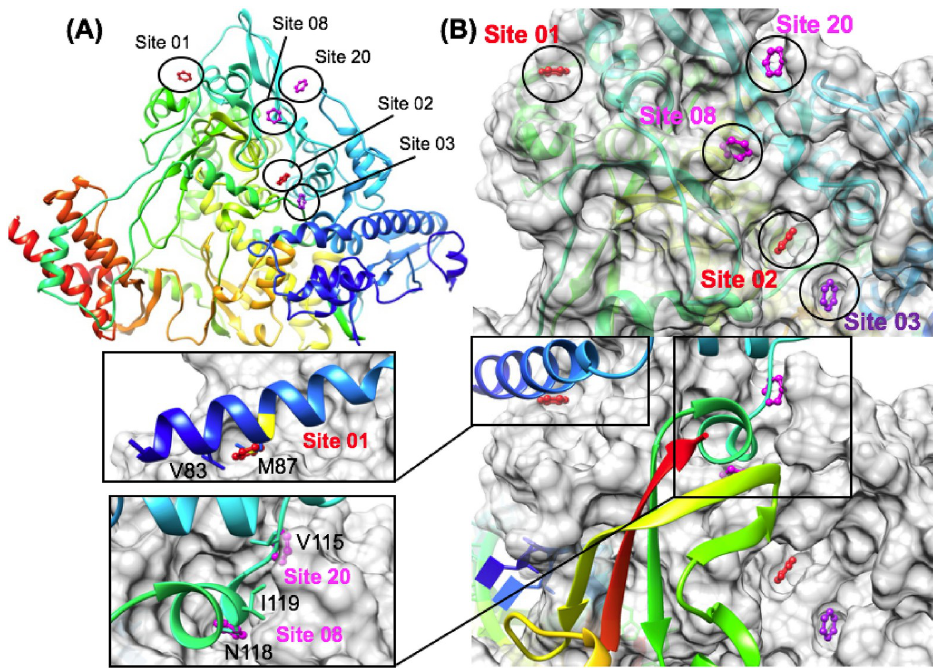
Fig 9. Favorable aromatic pharmacophore binding sites identified on the Nsp12 RdRp. Favorable sites are shown in red or magenta on the rainbow ribbon structure shown in (A) and on the gray binding surface shown in (B). Several protein-protein interaction (PPI) sites on the Nsp12 binding surface were identified as favorable aromatic pharmacophore binding sites shown in (B). Site 01 (red), Site 08 and Site 20 (magenta) represent Nsp12 / Nsp8 heterodimer interaction sites where the Nsp8 ribbon is shown (B) in rainbow binding to the complementary Nsp12 surface shown in gray. Zoom in surface views are shown to illustrate corresponding Nsp8 hydrophobic residues side chains that participate in PPI on the Nsp12